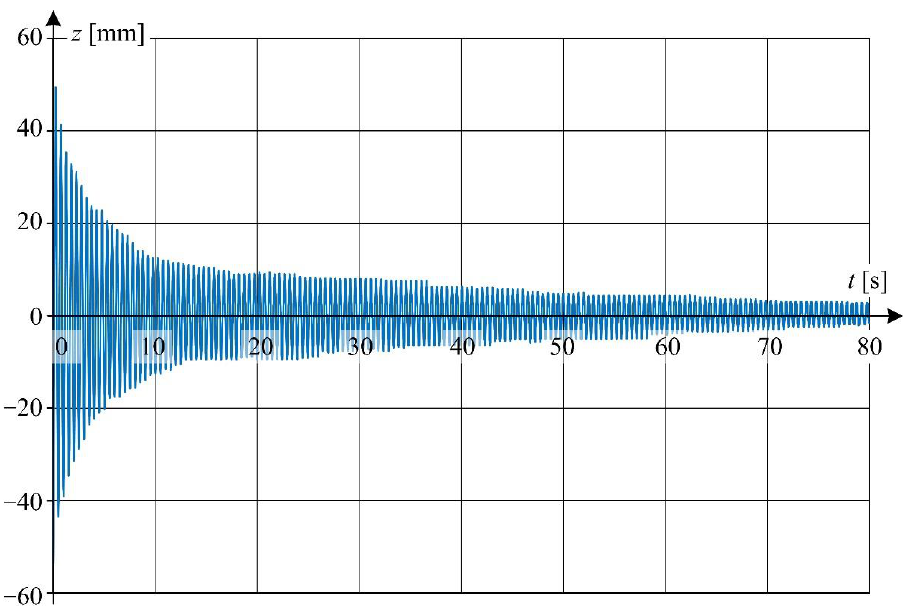
( b ) Figure 14. Detailed graphs of displacement waveform (Figure 13): ( a ) for the first 10 s of oscillation; ( b ) for 20 to 30 s of oscillation time. Figure 15 shows displacements along z – axis as functions of light point position x k (k = 1, 2, …, 8). It was assumed that the x – component is equal to zero at the excitation force application point situated between points 4 and 5. The figure also presents the instanta- neous shapes of the contact wire for selected times. The time t = 0 s was assumed the initial condition for the transient state caused by the rapid removal of the imposed force. The time stamps were selected in such a way as to correspond to the occurrence of the first and sixth maximum and minimum. Figure 15a shows the results for steady – state temper- ature of the contact wire equal to 27.7 °C, while Figure 15b for temperature of 73.0 °C.